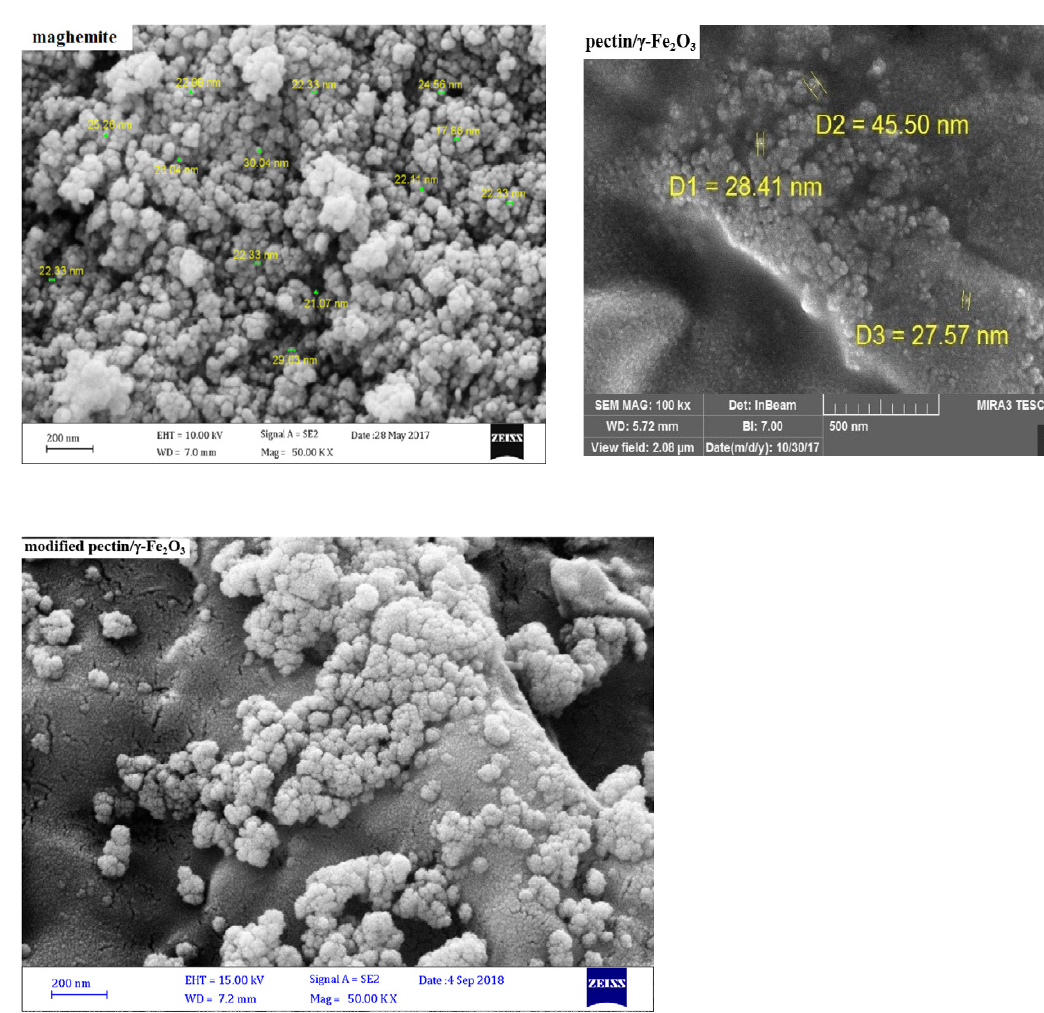
O nanocomposite, and pectin/ γ -Fe 2 3